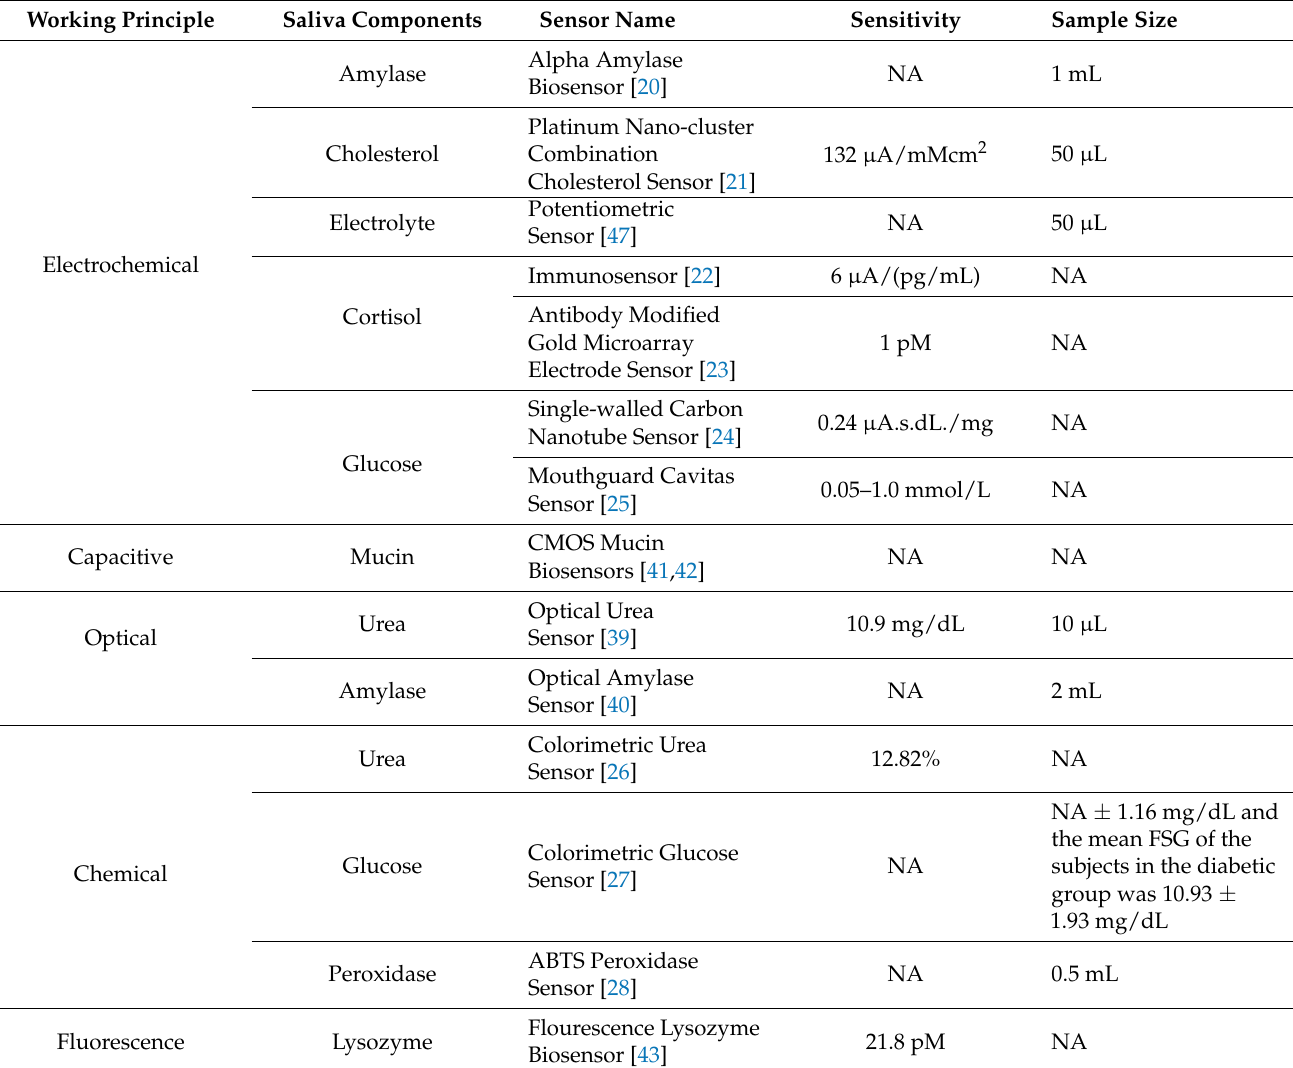
Table 2. Sensors of Organic and Inorganic Saliva